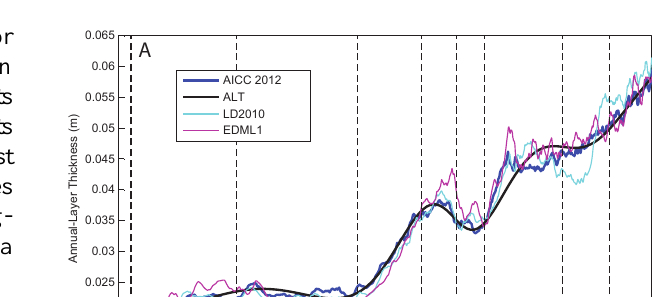
and EDML1 (Ruth et al., 2007). To derive the ALT timescale, from the AICC2012 timescale (Table 3) as well as a few tie from AICC2012 and ALT are shown in Fig. 6a. For most of the timescale, annual-layer thicknesses agree closely, and the age differences are less than 100 years (Fig. 6b). The largest difference occurs between 12.8 and 9.2 kyr, when ALT does not produce thick annual layers around 11.5 kyr. The thick layers in the AICC2012 are driven by high isotope values at the Antarctic Isotope Maximum 0